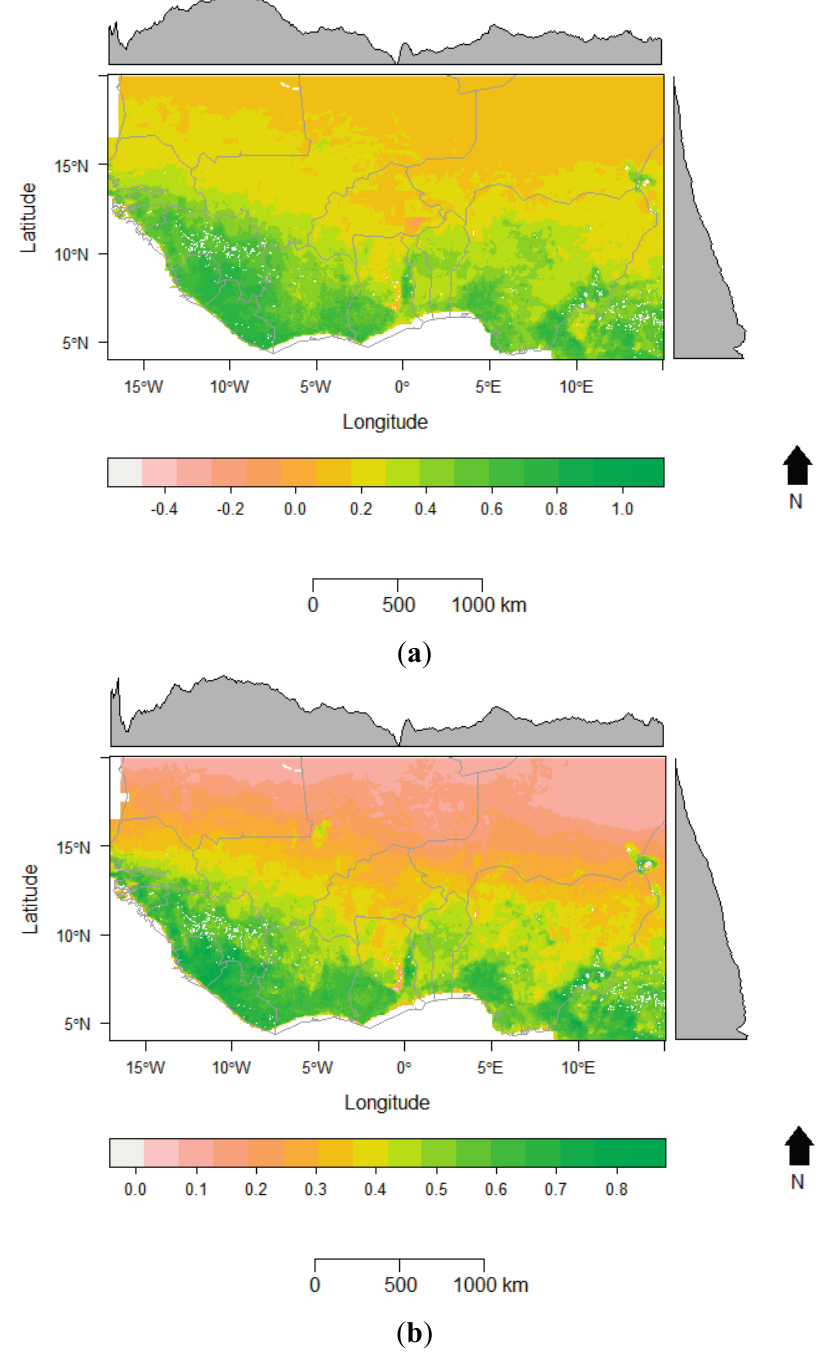
Figure 3. Intercept of NDVI in West Africa when ( a ) soil moisture is zero and ( b ) rainfall is